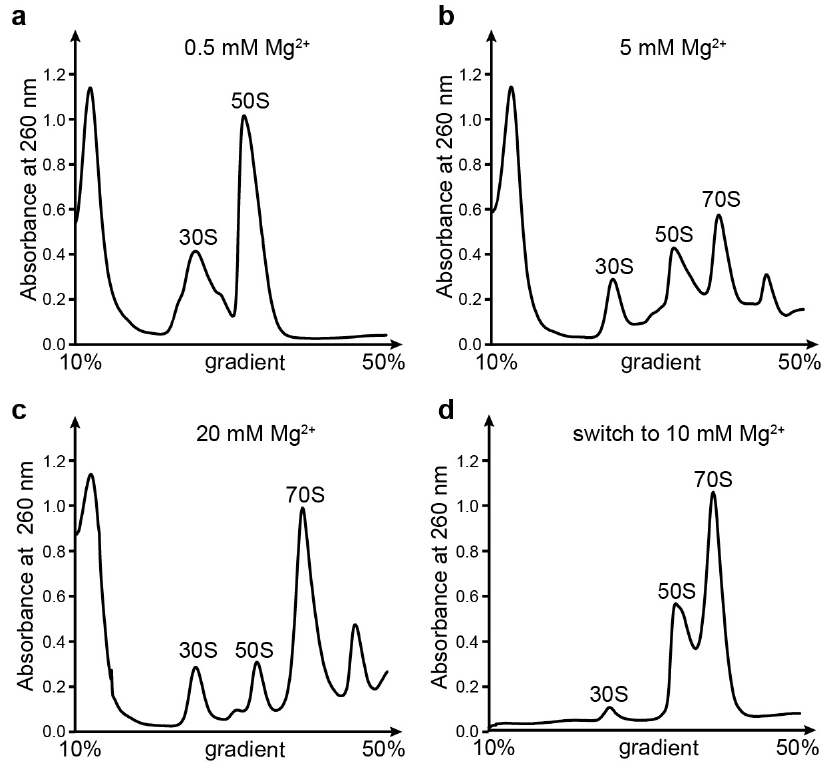
Figure 6. The effect of Mg 2+ concentration on the assembly of 70S . ( a – d ) Sucrose gradient profiles for crude 70S at 0.5 mM ( a ), 5 mM ( b ), and 20 mM ( c ) Mg 2+ concentrations. ( d ) Profile of 30S and 50S purified from 1 mM Mg 2+ in a gradient containing 10 mM Mg 2+ . Fractions corresponding to 30S and 50S under 1 mM Mg 2+ conditions (Figure 2a) were pooled, and sucrose was removed, followed by reloading onto a sucrose gradient containing 10 mM Mg 2+ .